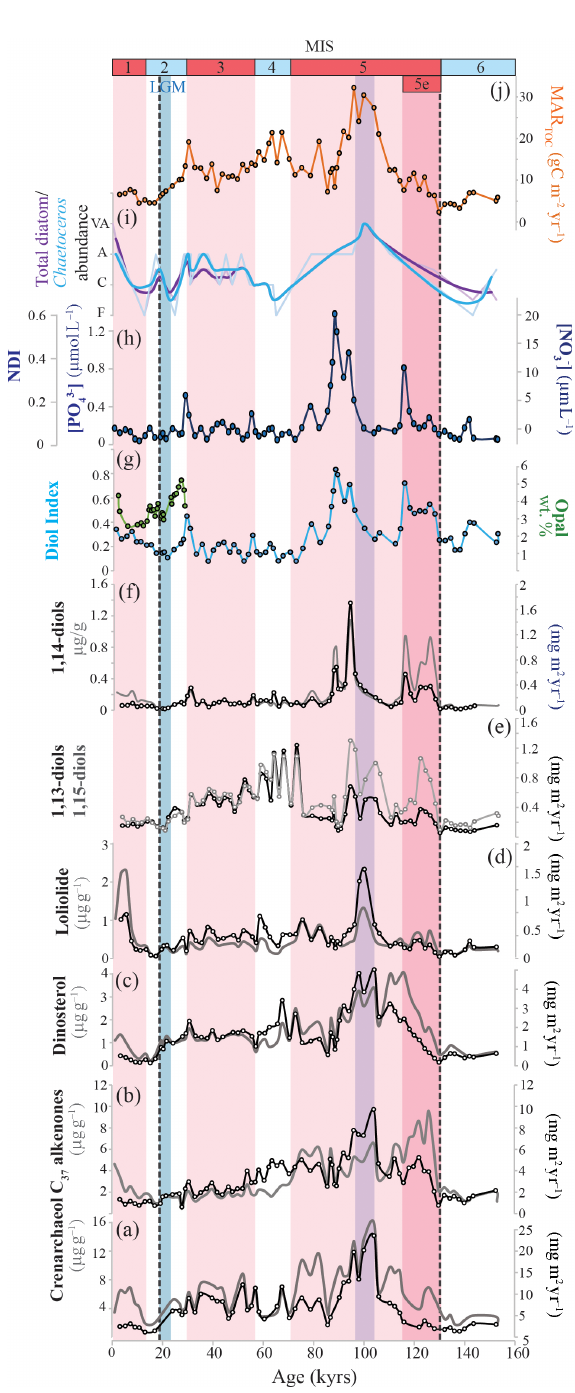
Figure 4. Biomarker proxy and accumulation records for ODP 1234. (a) Crenarchaeol concentrations and MARs. (b) C 37 alkenone con- centrations and MARs. (c) Dinosterol concentrations and MARs. (d) Loliolide concentrations and MARs. (e) 1,13- and 1,15-diol MARs. (f) 1,14-diol concentration and MARs. (g) Diol index (blue) and biogenic opal concentrations (green; Muratli et al., 2010b) for the last ∼ 28kyr. (h) Phosphate and nitrate concentrations calculated after the NDI. (i) Total diatom counts (purple) and Chaetoceros diatom counts (blue) (Mix et al., 2003). The thick smoothed lines reflect 2-point running averages of the diatom records. The counts are descriptive. F: few; C: common; A: abundant; VA: very abundant. (j) Mass AR of TOC. For panels (a) – (d) and (f) : concentrations are in grey and MARs are in black. The different color bands indicate different time periods: interglacial stages MIS 1, 3, and 5 in pink, including the MIS 5e in dark pink. The LGM is highlighted in blue. The purple band indicates the period of presumed enhanced upwelling. MIS ages are according to Lisiecki and Raymo (2005). The dashed lines indicate the onset ages of Terminations 1 (Pacific age of Stern and Lisiecki, 2014) and 2 (approximate